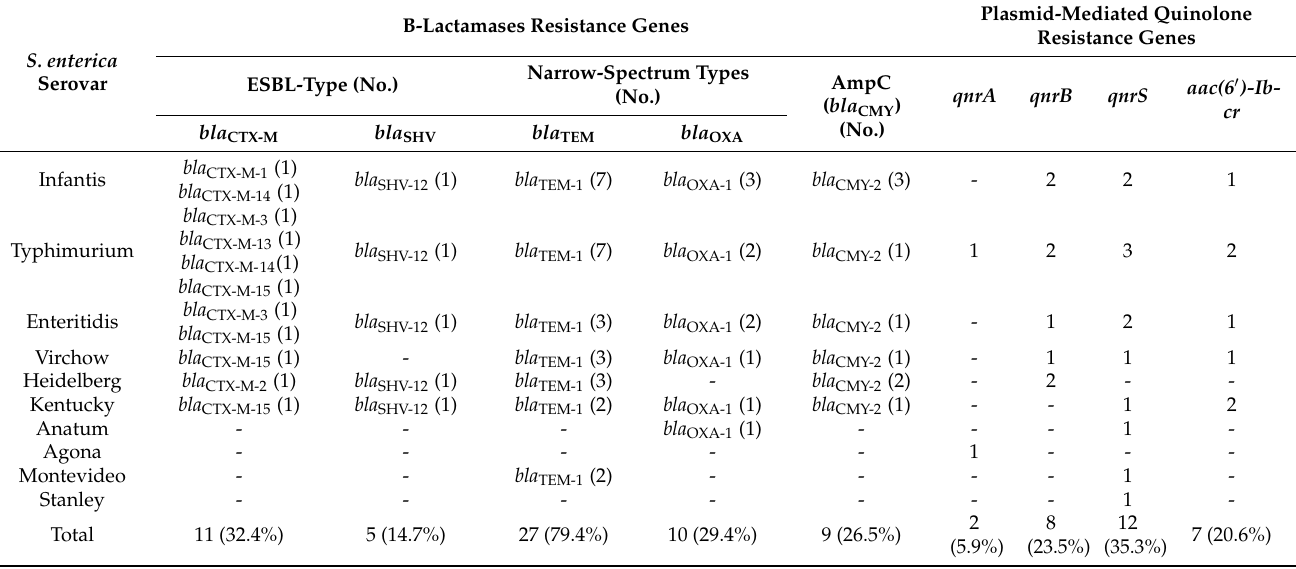
Table 2. Prevalence of resistance genes in Salmonella enterica serovars isolated from retail meats and beef carcasses in